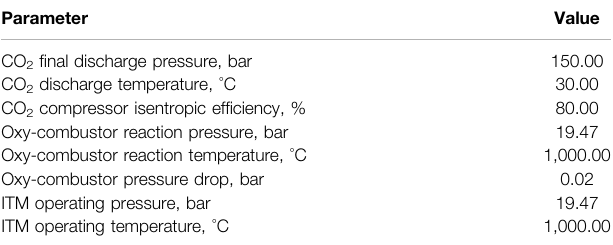
TABLE4| Importantdesignparametersfortheoxy-combustionCO 2